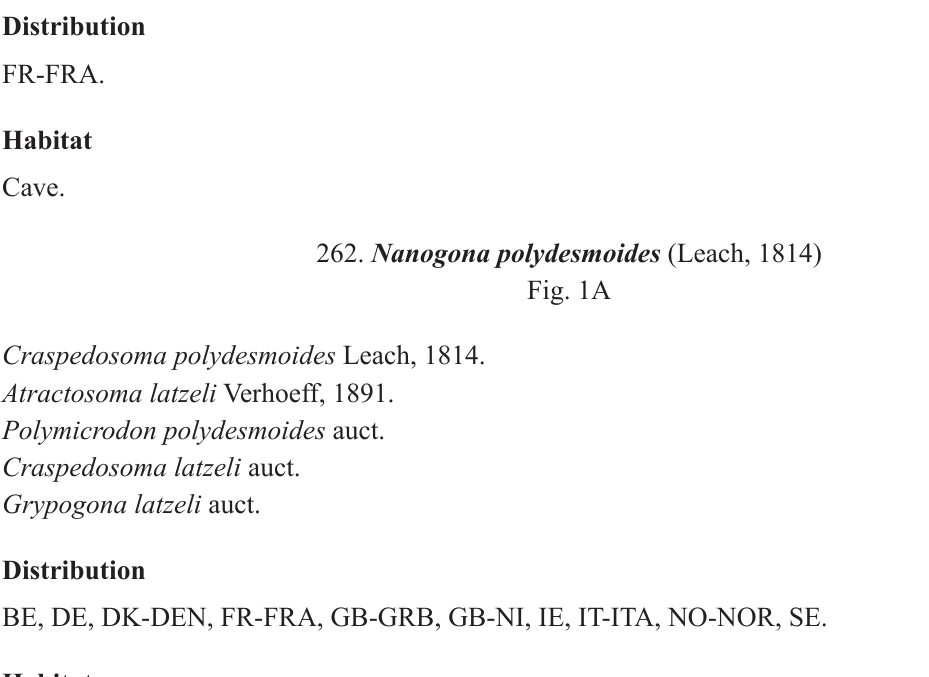
263. Nanogona uncinata (Ribaut,